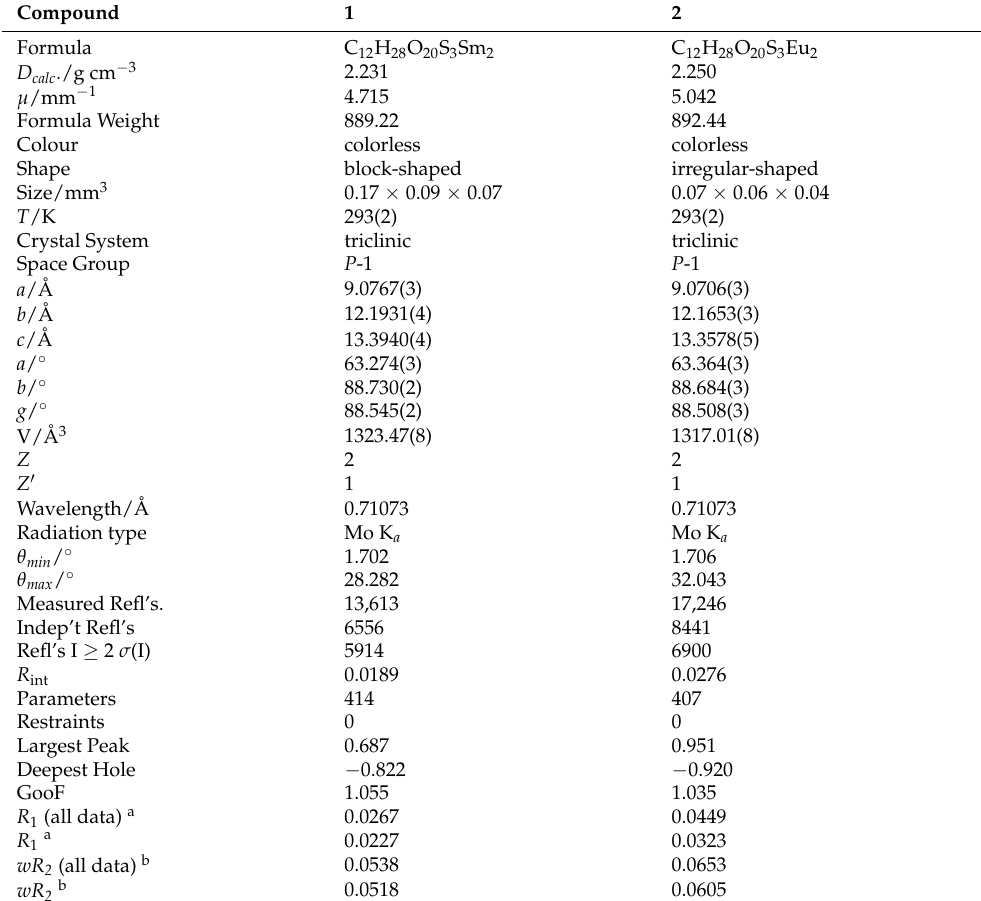
Table 1. Crystallographic data and structure refinements for compounds 1 and 2